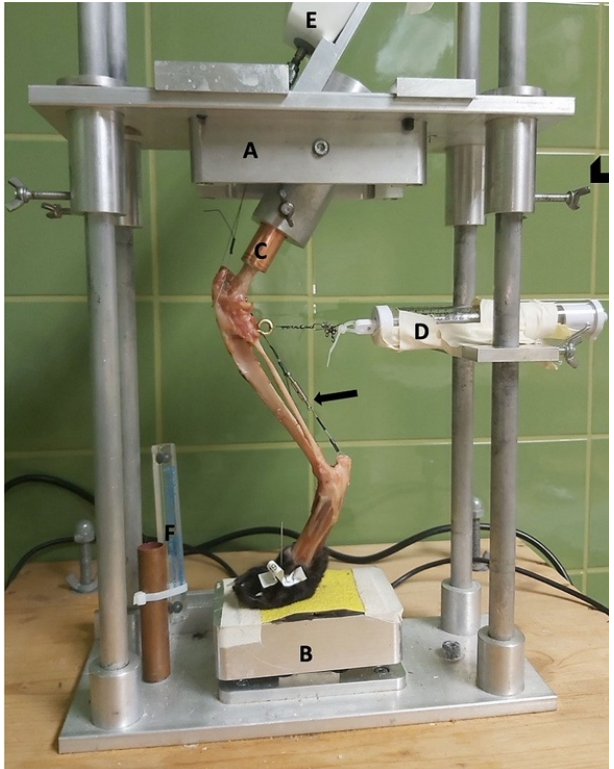
Figure 1. Limb press. A = top plate; B = pedestal; C = copper tube holding the femoral shaft; D = spring mechanism to avoid slack; E = force gauge; and F = radiographic magnification marker (Biomedtrix, Whippany, NJ, USA). Arrowhead = screws to fixate the top plate. Arrow = Achilles tendon mechanism.